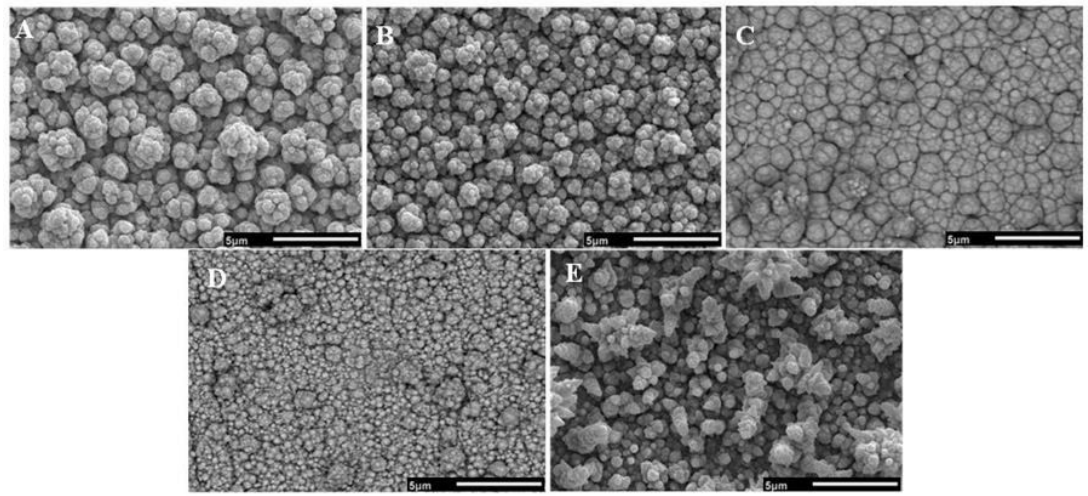
Figure 3. Surface morphology for the Cu-Sn coatings produced by DC electrodeposition, using (A) j = 50 A m -2 (Experiment 2); (B) j = 80 A m -2 (Experiment 3); (C) j = 100 A m -2 (Experiment 4); (D) j = 150 A m -2 (Experiment 5); (E) j = 200 A m -2 (Experiment 6). Magnification of 5000x.